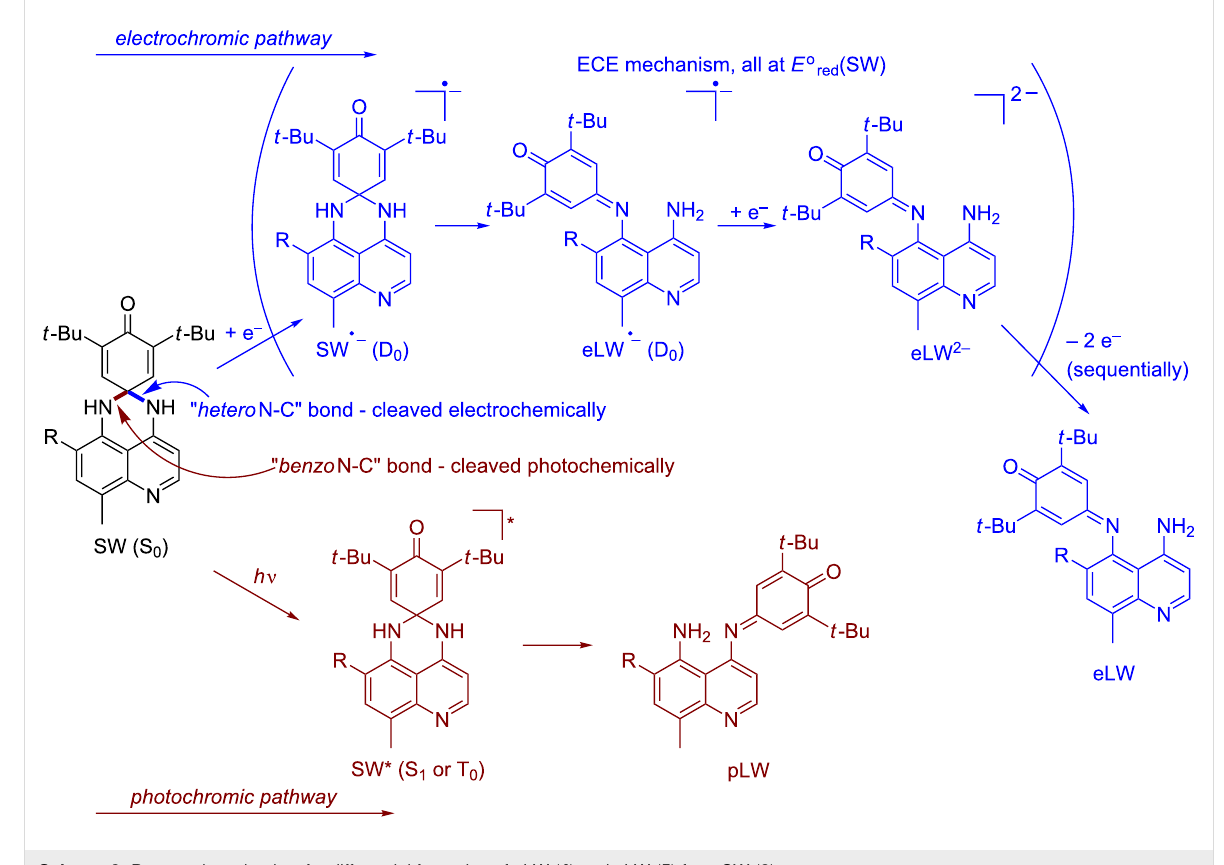
Scheme 3: Proposed mechanism for differential formation of pLW ( 4 ) and eLW ( 5 ) from SW ( 3 ).